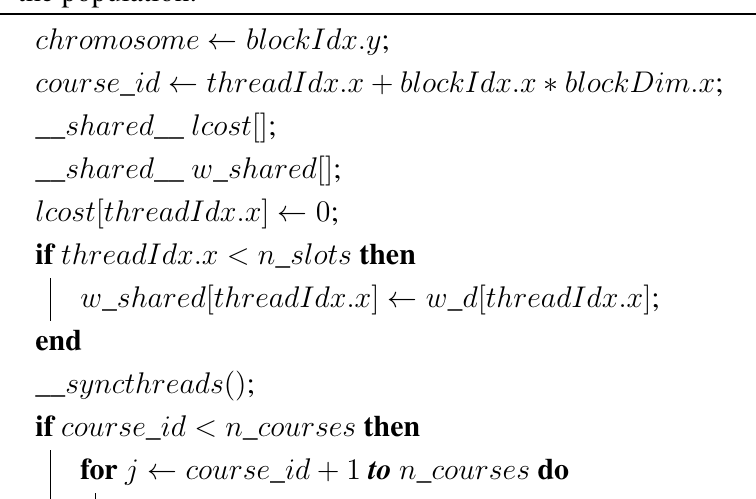
Algorithm 3: Evaluation, examination-threaded approach: each thread evaluates one gene of the